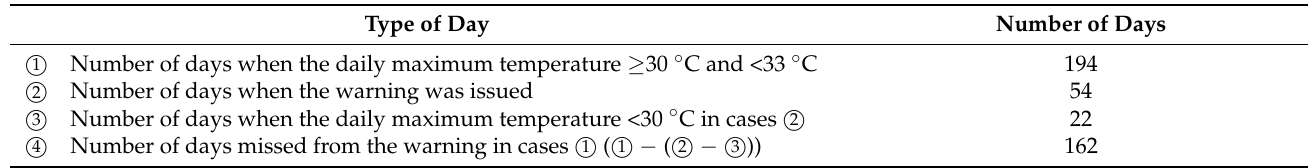
Table 1. Number of days on which warning was issued in Seoul, from 2011 to 2018 (based on the assumption that a warning was issued from two days before the daily maximum temperature reached the threshold temperature of mortality (33 ◦ C)).